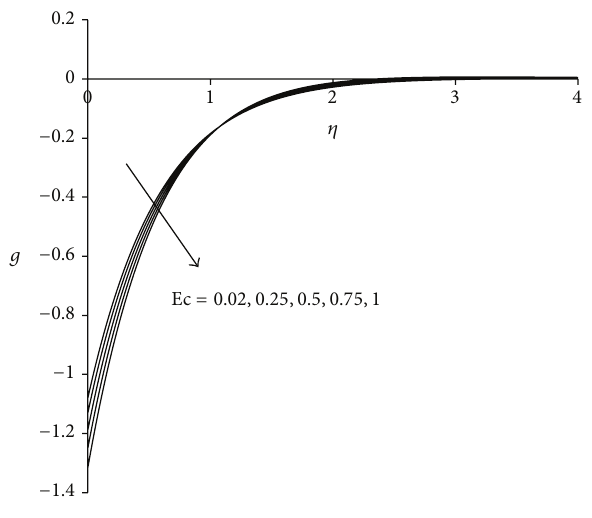
Figure 12: Microrotation distribution for different Ec (𝜆 = 3, 𝜏 = 1, 𝜎 = 3) .